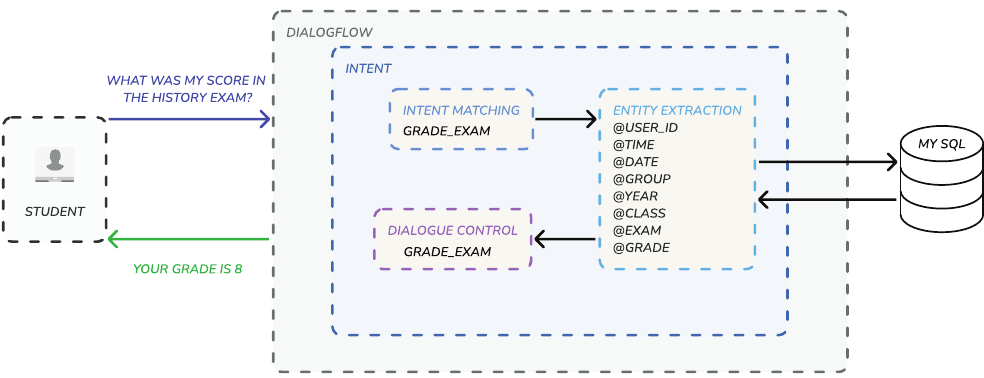
Figure 7. Intent is the main unit of work in Dialogflow. Thanks to their processing, it is possible to obtain entities to perform operations and hold conversations with